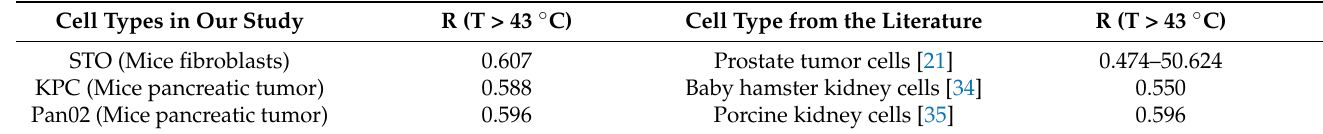
Table 3. Calculated R CEM values for pancreatic cancer cells compared to other cell lines.